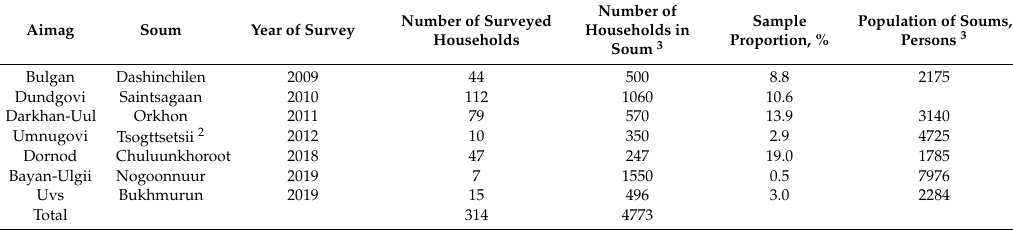
Table 2. Main characteristics of the surveys conducted in the model areas in Mongolia 1 . Aimag Soum Year of Survey Number of Surveyed Households